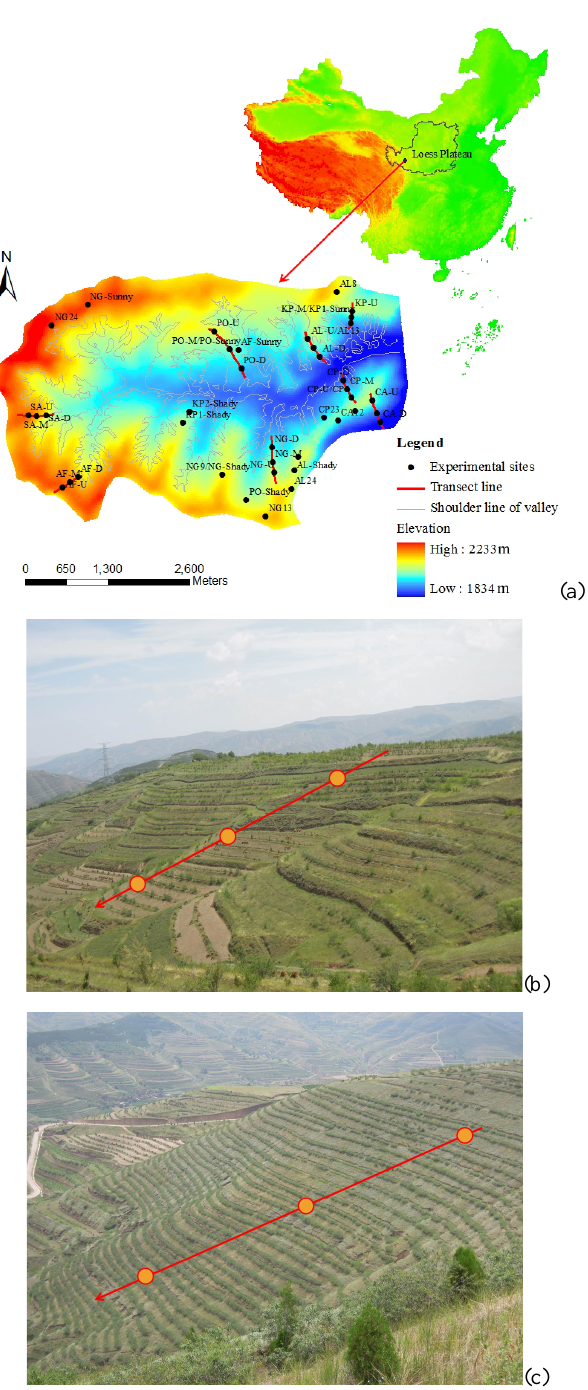
Fig. 1. Location of the study area and experimental sites. (a) Loca- tion of the study area in the Loess Plateau and experimental sites in watershed; (b) photo of alfalfa grassland transect (land con- verted from farmland and planted with alfalfa); (c) photo of kor- shinsk peashrub shrubland transect (land converted from farmland and planted with korshinsk peashrub). Note: NG represents native grassland; PO represents farmland planted with potato; AF repre- sents abandoned farmland; AL represents alfalfa; KP represents ko- rshinsk peashrub; CP represents Chinese red pine; CA represents Chinese arborvitae; SA represents Siberian